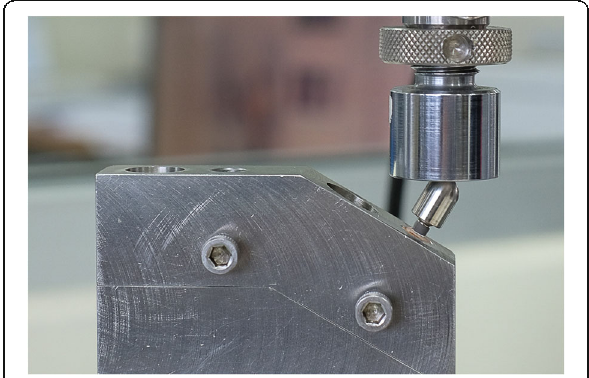
Fig. 6 Specimen mounted in a 30°-angled steel